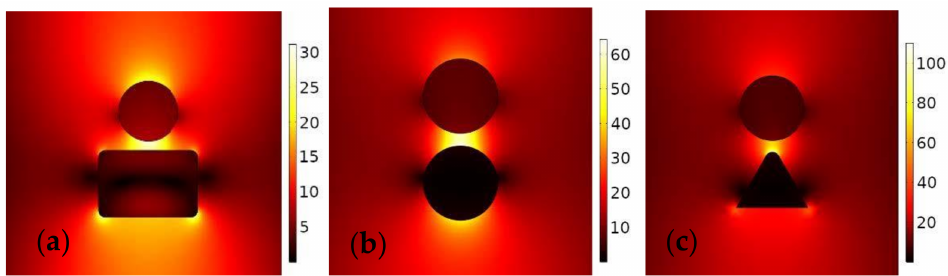
Figure 9. Electric field distribution of different waveguides: ( a ) cylinder-rectangle waveguide; ( b ) double-cylinder waveguide; ( c ) proposed cylinder-triangular waveguide.